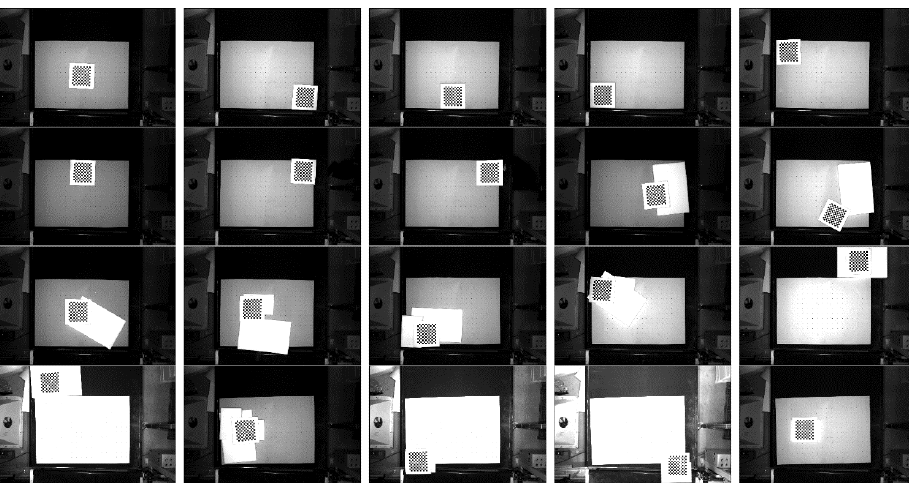
Figure 6. Camera calibration sample collection.